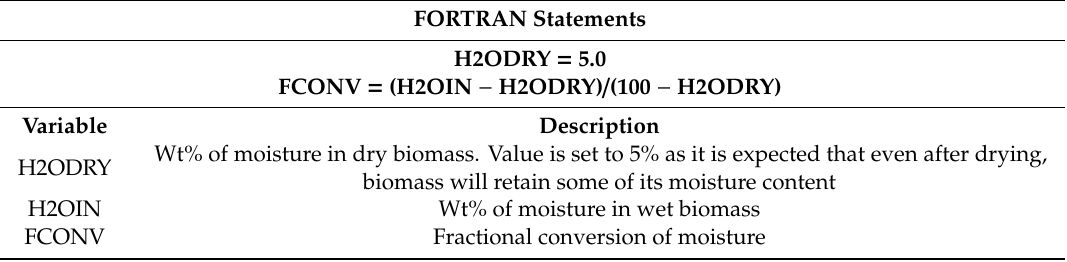
Table A1. FORTRAN statements for calculating moisture (WATER Calculator Block).